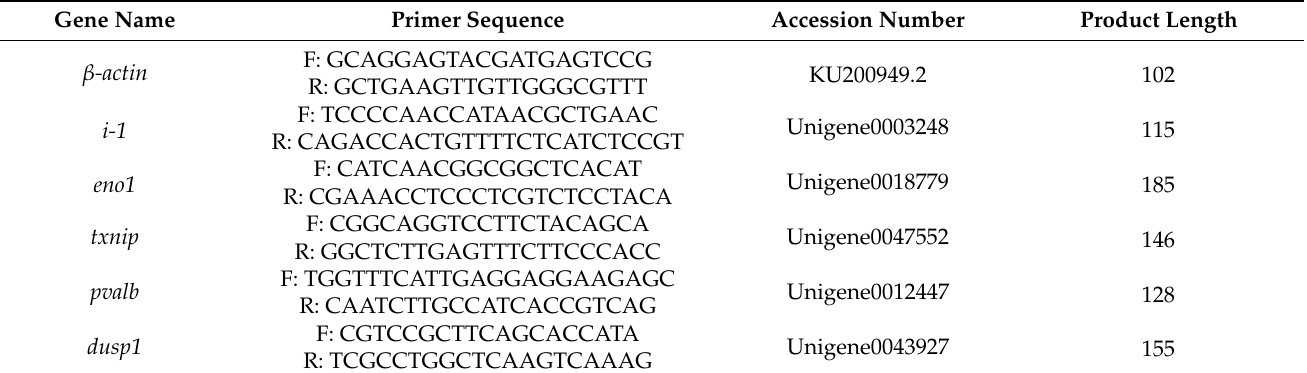
Table 2. Primer sequences for RT-qPCR verification.